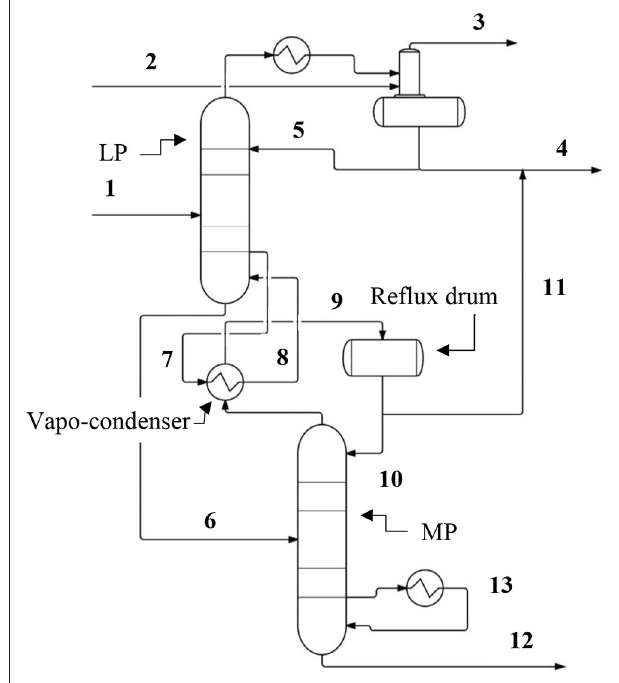
FIGURE 3 | A simplified diagram of the split column separations systems. Process and component labels are shown where they have not already been identified in Figure 2 . The streams are identified by numbering as follows: (1) Feed comprising approximately 50% methanol (molar); (2) Carrier gas; (3) Waste gas (CO 2 and carrier gas); (4) Methanol product; (5) Reflux stream; (6) MP stream enriched in water; (7 and 8) LP column reboiler stream; (9 and 10) MP column reflux stream; (11) Methanol product; (12) Bottoms (waste water); (13) MP column reboiler